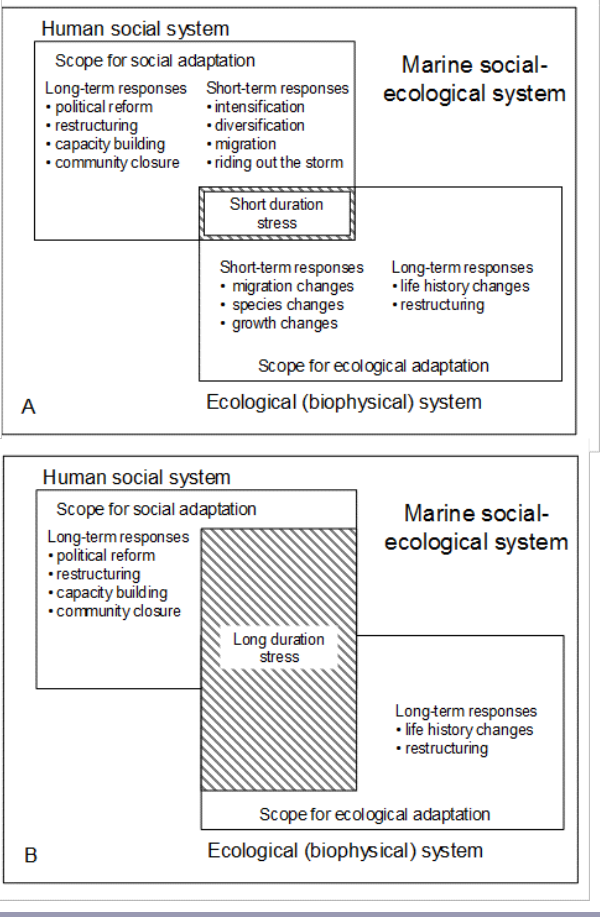
Fig. 1. Coping responses at short-time scales (A) and adaptive responses at longer-time scales (B). Recreated from Perry et al.